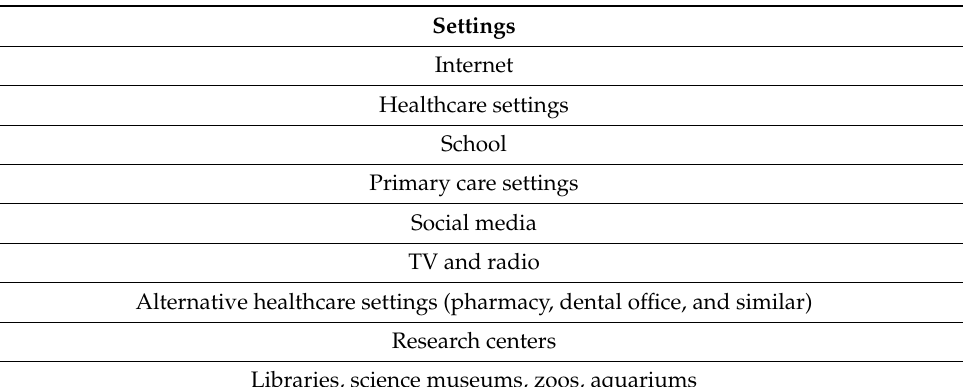
Table 5. Items selected in the category “Settings for citizens’ educational initiatives”, listed by decreasing mean scores from the Delphi process.